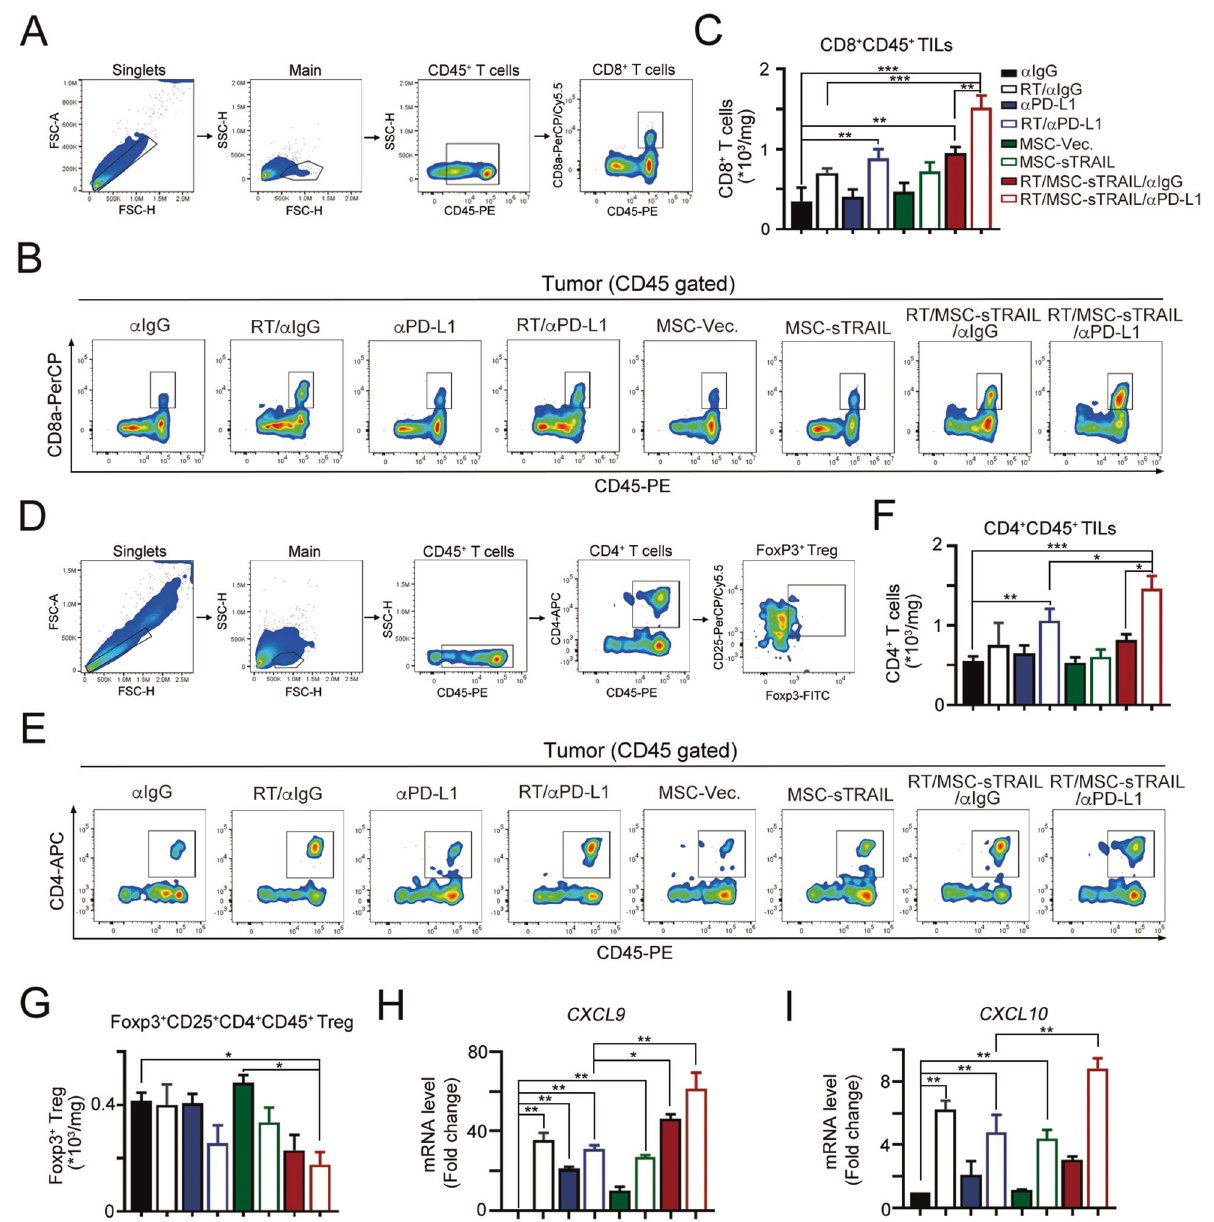
within resected tumors was evaluated by fl ow cytometry (mean ± SEM, n = 3). *** p < 0.001. G The tumor-in fi ltrating Foxp3 + Treg cells within resected tumors was evaluated by fl ow cytometry (mean ± SEM, n = 3). * p < 0.05 and ** p < 0.01. H The level of CXCL9 mRNA within the tumor microenvironment was evaluated by qRT-PCR (mean ± SEM, n = 3). * p < 0.05 and ** p < 0.01. I The level of CXCL10 mRNA within the tumor microenvironment was evaluated by qRT-PCR (mean ± SEM, n = 3). * p < 0.05 and ** p <